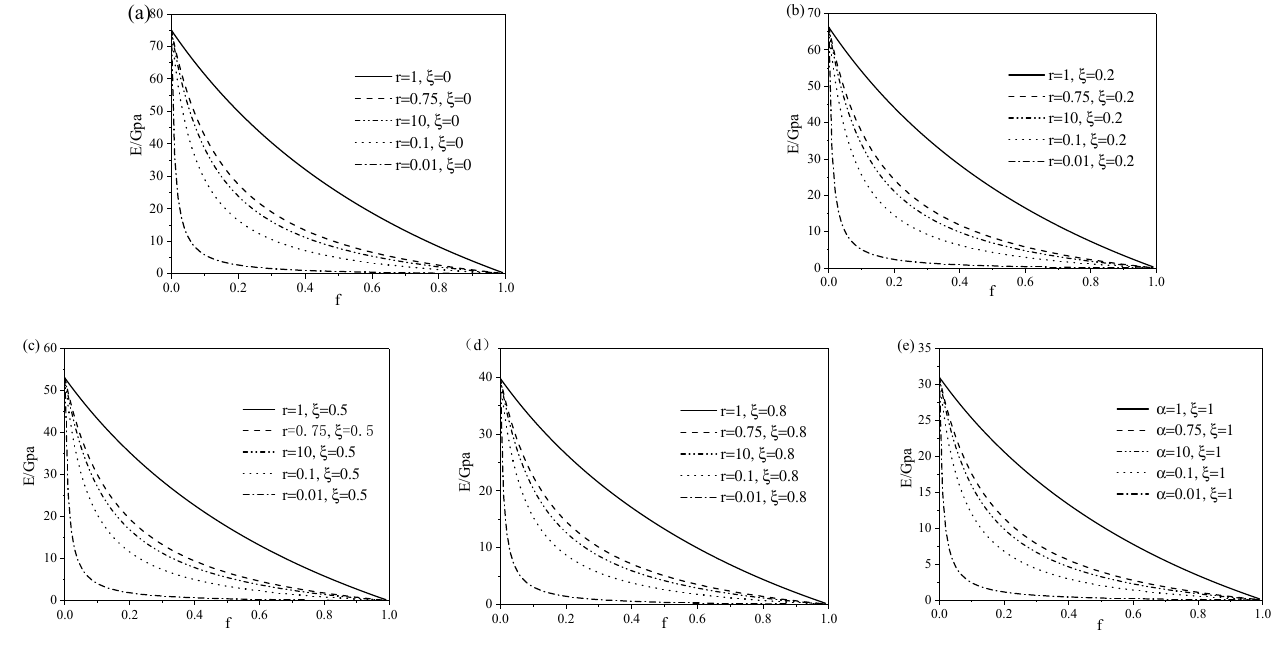
Figure 3. Relationship between Young’s modulus in different phase states and the porosity of porous SMA with the aspect ratio of 0.01, 0.1, 0.75, 1, and 10: ( a ) pure austenitic phase, ( b ) mixed martensite and austenite phase at ξ = 20%, ( c ) mixed martensite and austenite phase at ξ = 50%, ( d ) mixed martensite and austenite phase at ξ = 80%, and ( e ) pure martensite phase.